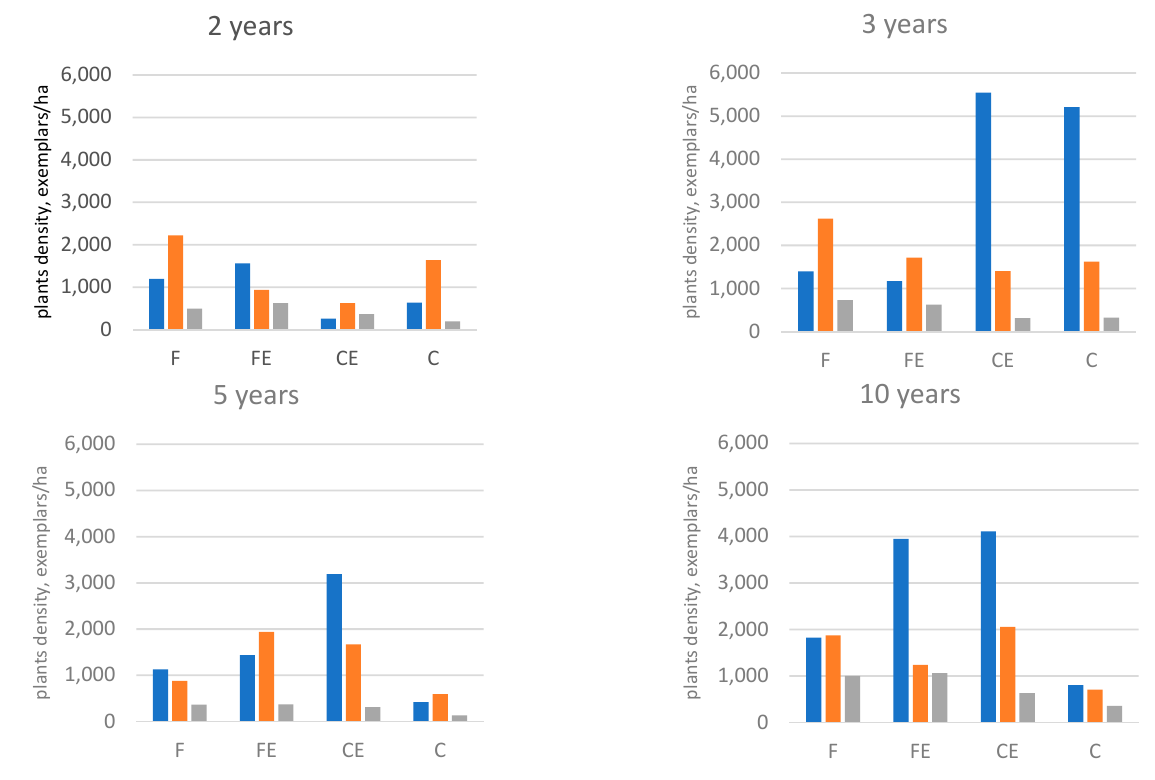
Forests 2021 , 12 , x FOR PEER REVIEW